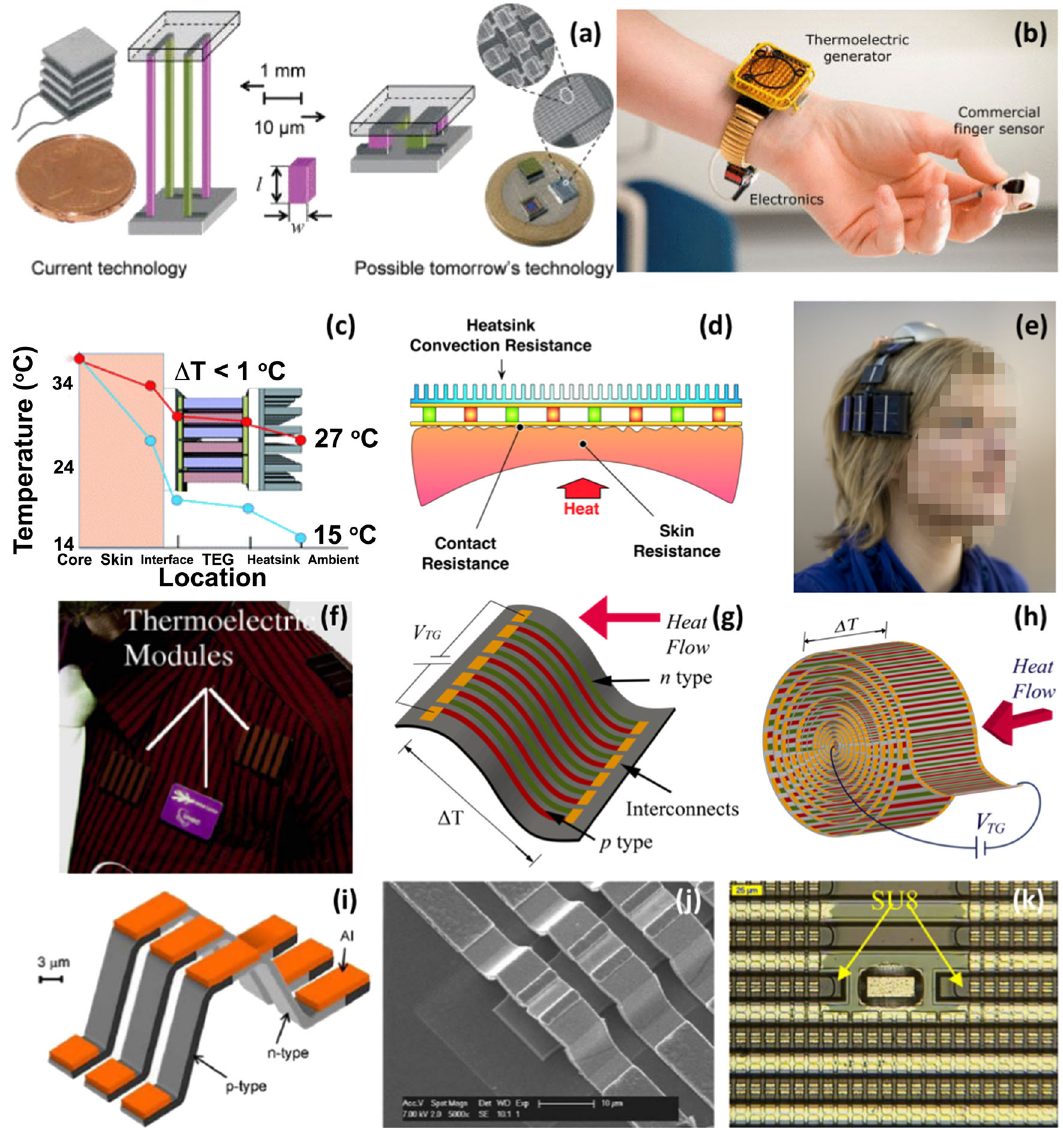
Fig. 5 Thermal energy generators. a Current (left) and futuristic (right) view of TE generators. b Body-powered wireless pulse oximeter. c Temperature difference from core body to the ambient air. d 2D schema of parasitic resistances impacting TE performance. Reprinted with permission from Suarez et al. 41 Copyright © 2016, Royal Society of Chemistry. Wearable and wireless energy source-based module, consisting of a thermoelectric energy generator and a PV cell, harvesting energy from human e head and f body. Reprinted with permission from Leonov et al. 54 Copyright © 2009, AIP Publishing. g 3D schema of a fl exible TE based on Si microwires with tremendous potential for high compact rolled structures ( h ). 36 i 3D schema and j SEM image of three thermocouples, and k an optical micrograph cross-section, showing their bonding. Reprinted with permission from Su et al. 142 Copyright © 2009,